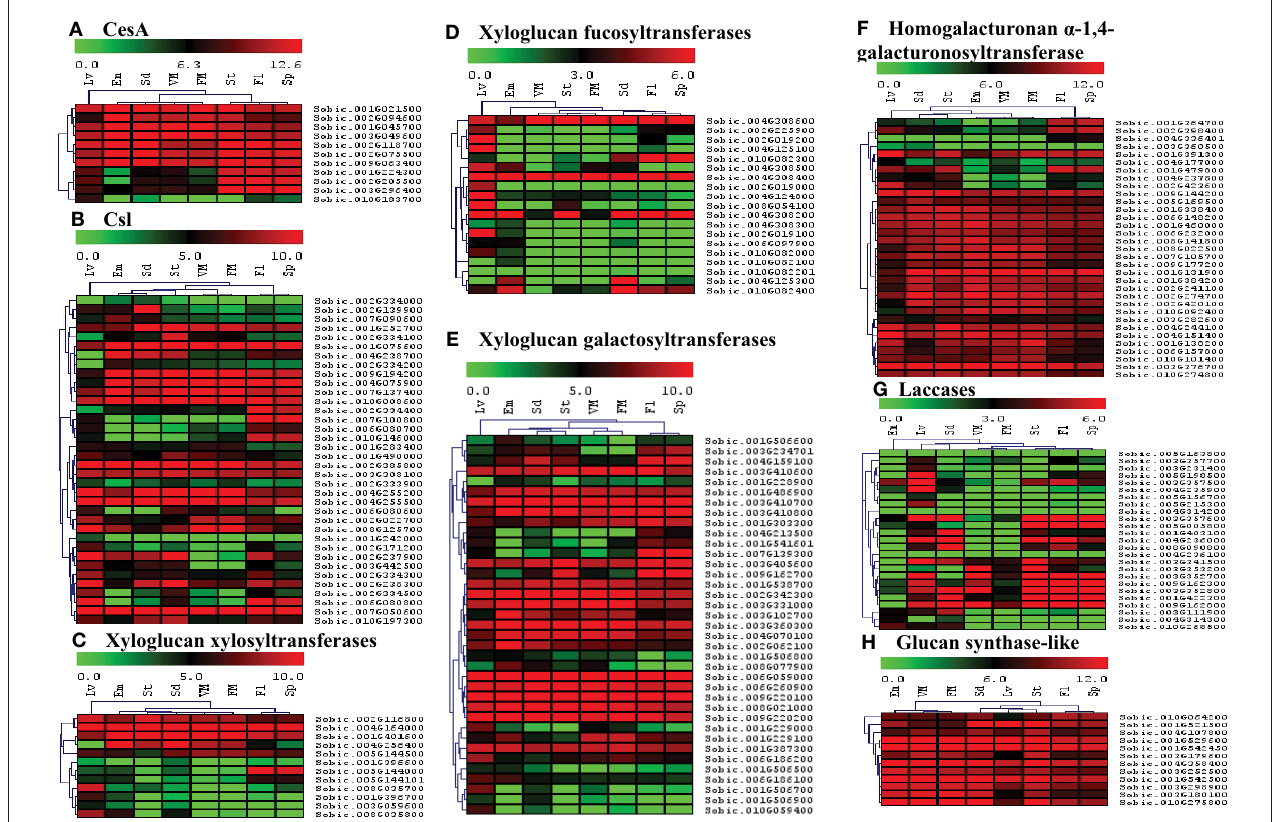
FIGURE 6 | Heat map showing hierarchical clustering of the sorghum’s cell wall related biosynthetic gene families in various developmental stages. (A) CesA, (B) Csl, (C) Xyloglucan xylosyltransferases, (D) Xyloglucan fucosyltransferases, (E) Xyloglucan galactosyltransferases, (F) Homogalacturonan α -1,4-galacturonosyltransferase, (G) Laccases, (H) Glucan synthase-like. RNA-seq data from various developmental stages viz. stem (St), 20 days old leaves (Lv), vegetative meristem (VM), floral meristem (FM), spikelet (Sp), flowers (FL), embryos (Em), and seeds (Sd) were mapped on gene sequences related to above gene families. The respective RPKM values were used to construct heatmap with scale bar on the top showing expression of the genes. Red colors represent high expression whereas green represents low expression.